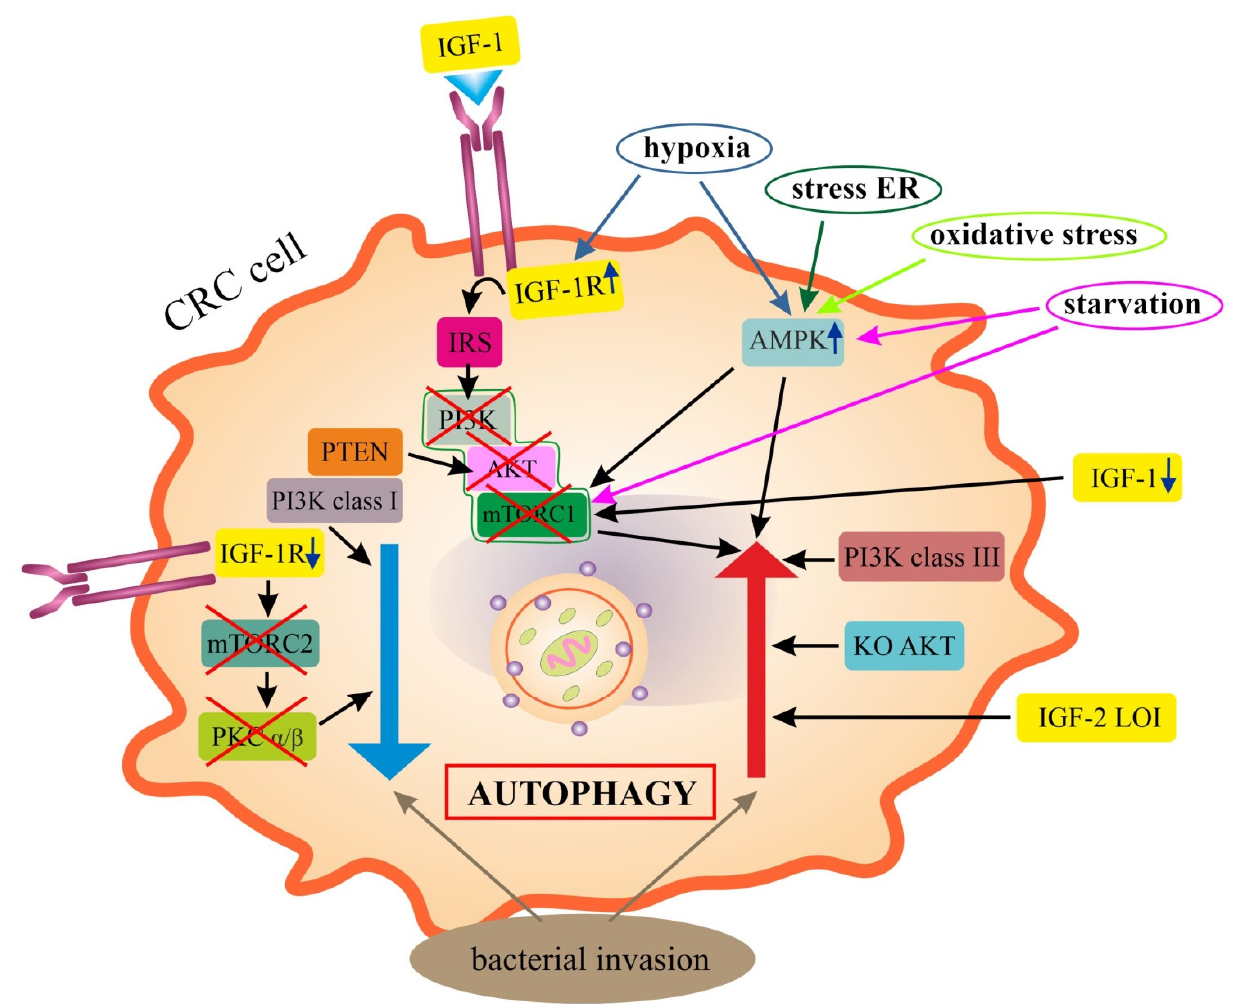
Figure 2. Schematic summary of the findings on the role of IGF system in the regulation of autophagy in colorectal cancer (CRC) cells. Neoplastic cells show both induction of autophagy ( ↑ ) and inhibition of autophagy ( ↓ ). Autophagy is promoted by IGF-1R, whose overexpression under hypoxia inhibits PI3K/AKT/mTORC1 signaling. Inhibition of mTORC1 also occurs under the impact of a decrease in IGF-1 and starvation. Autophagy is directly enhanced by class III PI3K, knockout of AKT and IGF-2 LOI. Inhibition of autophagy in CRC cells is mediated by IGF-1R depletion, through inhibition of mTORC2 and PKC α / β , as well as class I PI3K. Bacterial invasions of the colonic mucosa can both stimulate and inhibit autophagy. Legend: ↑ / ↓ : increase, stimulation/decrease, inhibition; → : lead to; AKT: serine/threonine kinase; AMPK: 5 (cid:48) adenosine-monophosphate-activated protein kinase; CRC: colorectal cancer; IGF-1/2: insulin-like growth factor 1/2; IGF-1R: IGF receptor type 1; IGF-2 LOI-IGF-2 loss of imprinting; IRS: insulin-receptor substrate; ER: endoplasmic reticulum; KO AKT: knockout of AKT gene; mTORC1/2: mammalian target of rapamycin complex 1/2; PI3K class I or III: phosphatidylinositol-3-kinase class I or III; PKC α / β : protein kinase C alpha/beta; PTEN: phosphatase and tensin homolog deleted on chromosome